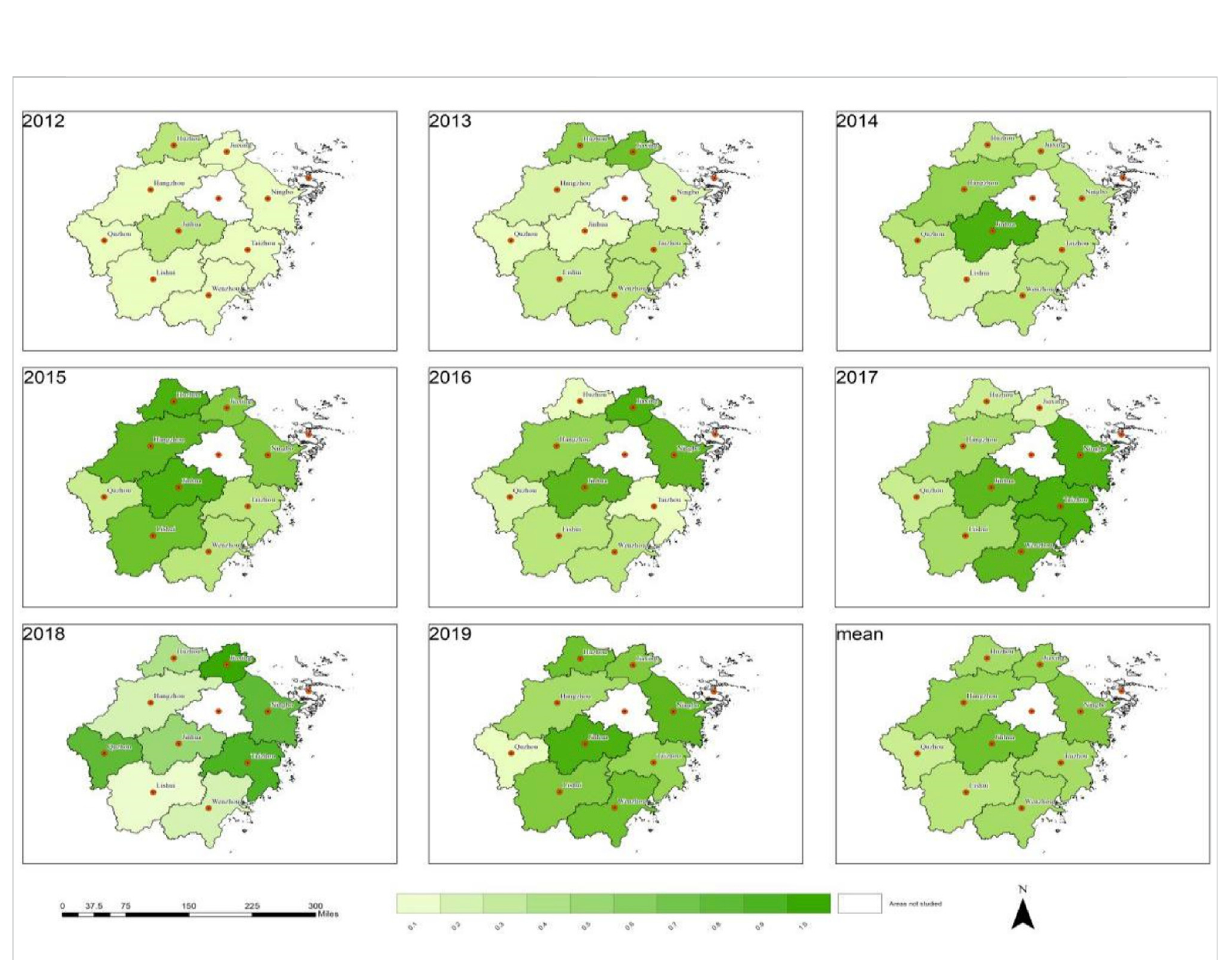
FIGURE 2 Spatial – temporal evolution of green fi nance in nine cities in Zhejiang Province (2012 –